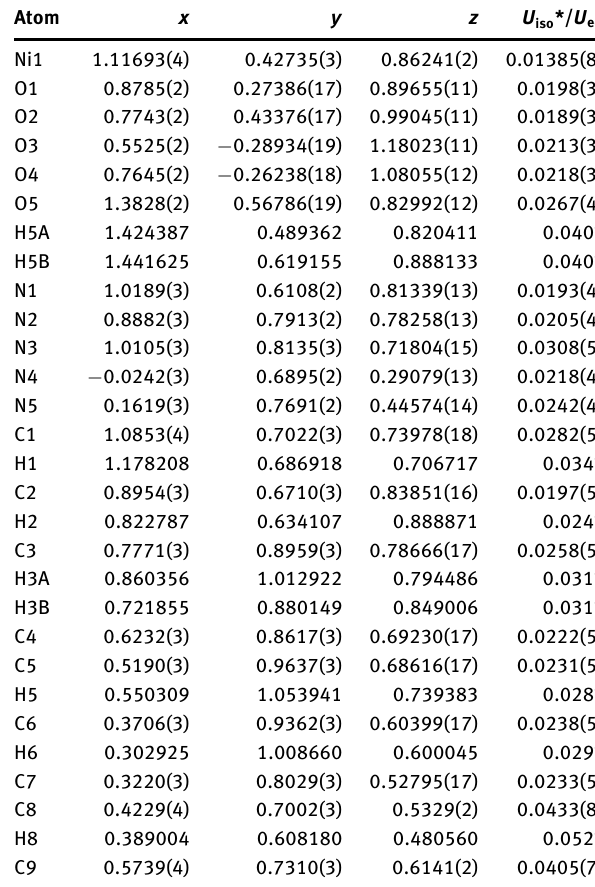
Table 2: Fractional atomic coordinates and isotropic or equivalent isotropic displacement parameters (Å 2